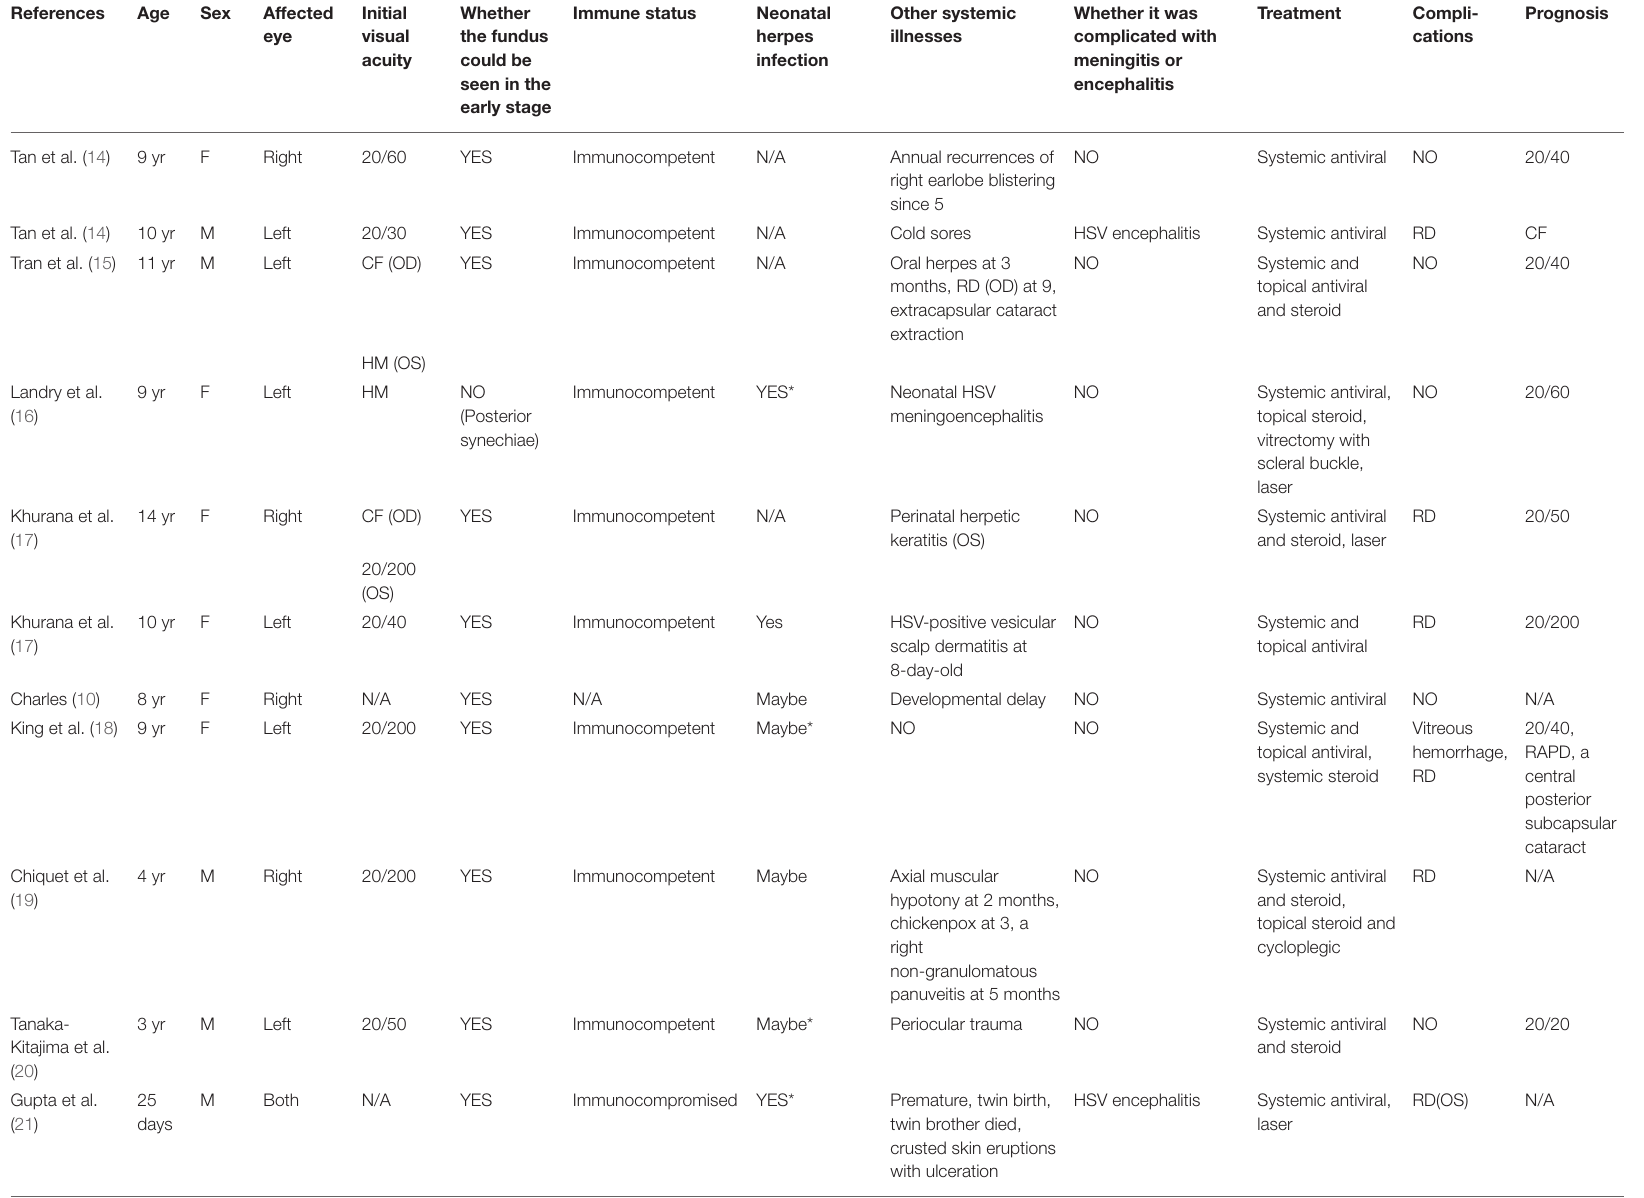
TABLE 1 | Published cases of pediatric ARN with